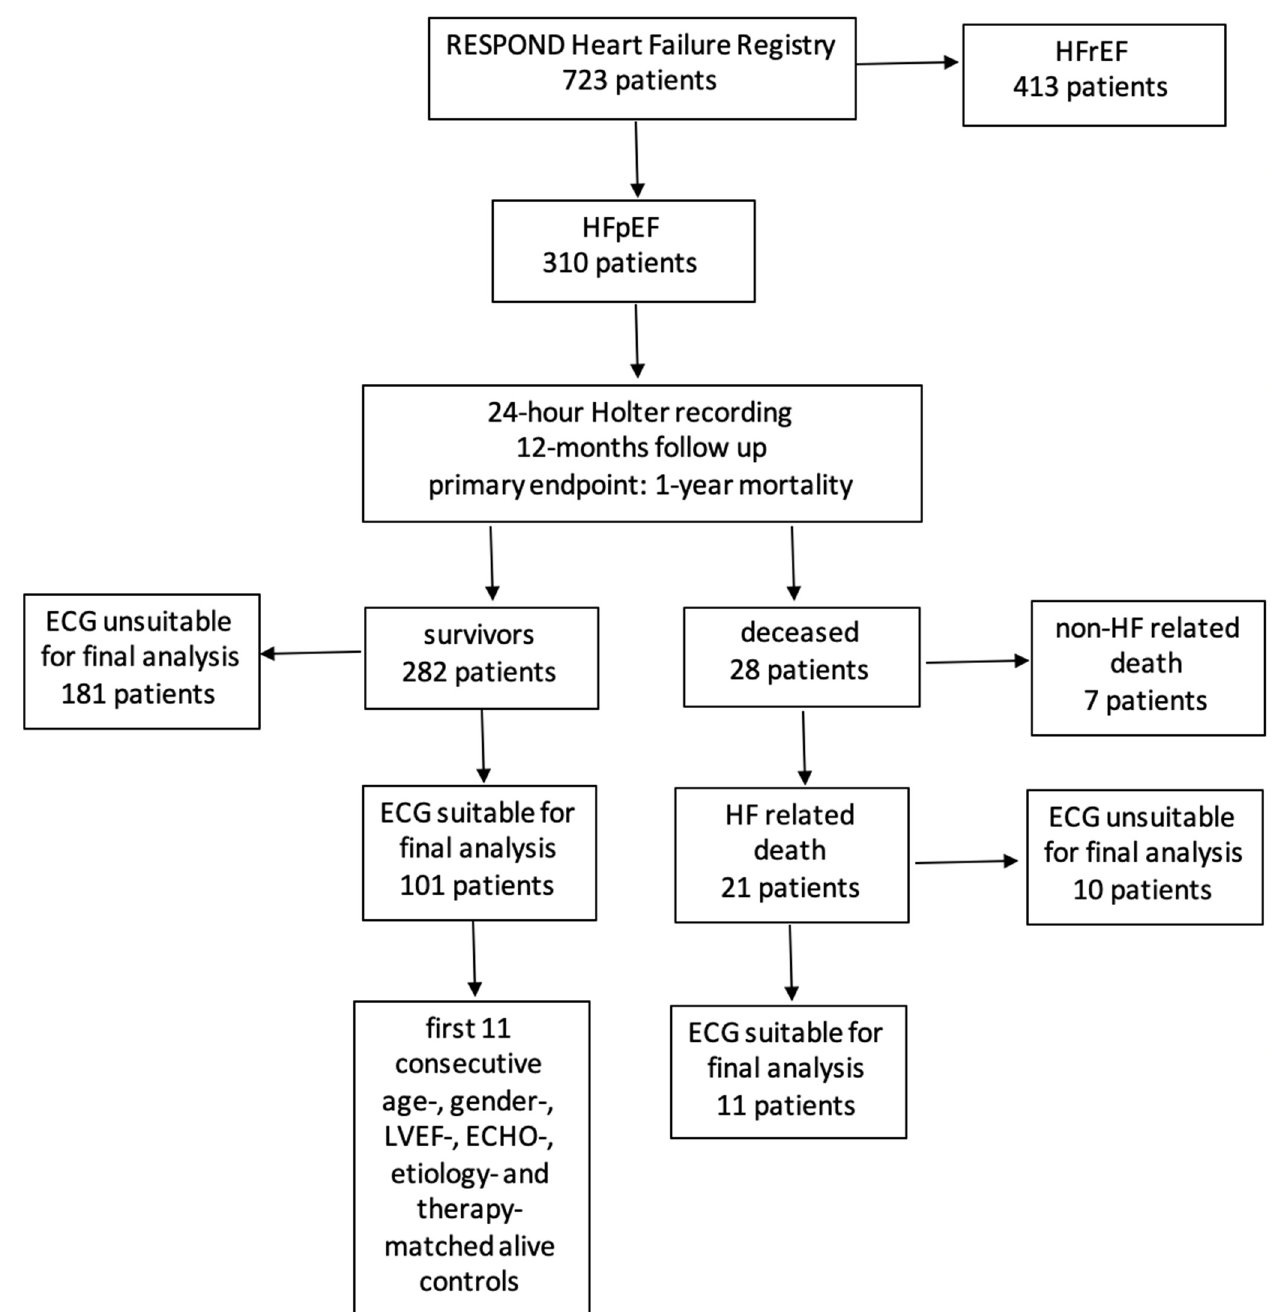
Figure 1. Patient flow diagram.